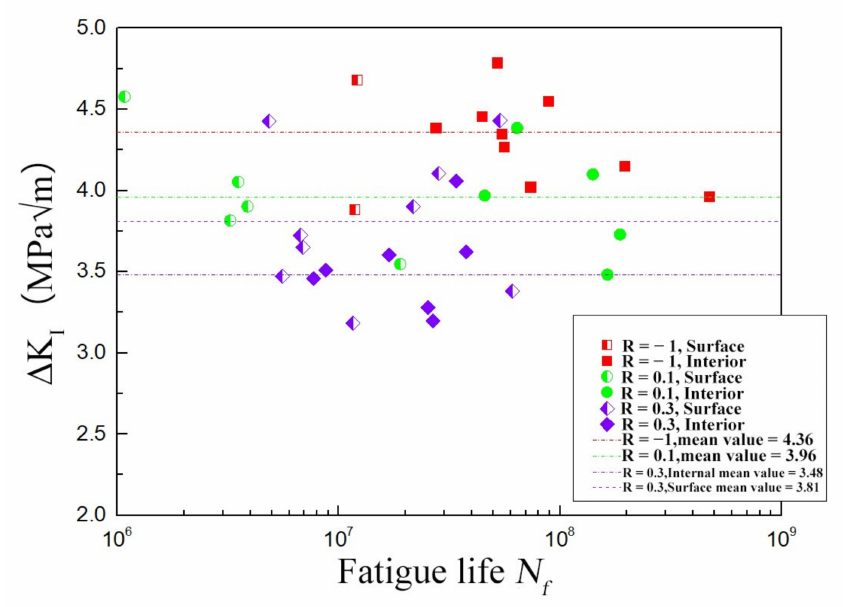
Figure 10. Values of ∆ K I at different